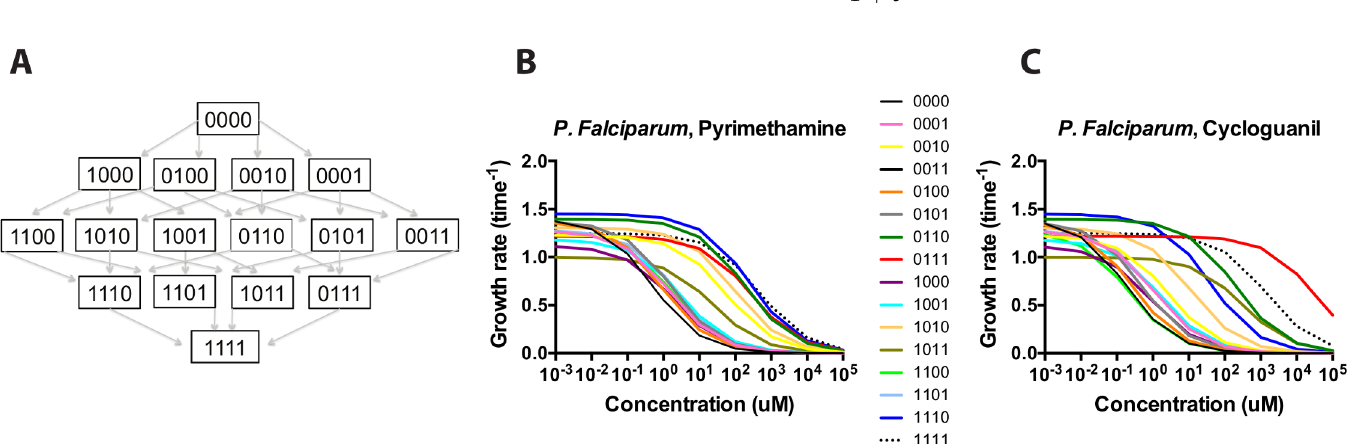
Fig 1. P . falciparum resistance to pyrimethamine (PYR) and cycloguanil (CYC): Basic structure of the adaptive landscape and growth rates across drug environment. (A) Basic structure of available pathways between the ancestor (0000) and quadruple mutant (1111). 0000 corresponds to the wild-type DHFR genotype, with 1111 the mutated protein at each of four sites (N51I, C59R, S108N, and I164L). (B, C) Growth curves for the P . falciparum alleles in pyrimethamine and cycloguanil, simulated from previously measured empirical measurements [11,12]. Growth rates are in terms of time -1 . The x -axis is in terms Log 10 of the drug concentration (uM). Note the subtle differences between the growth rate curves for the individual alleles across the two related